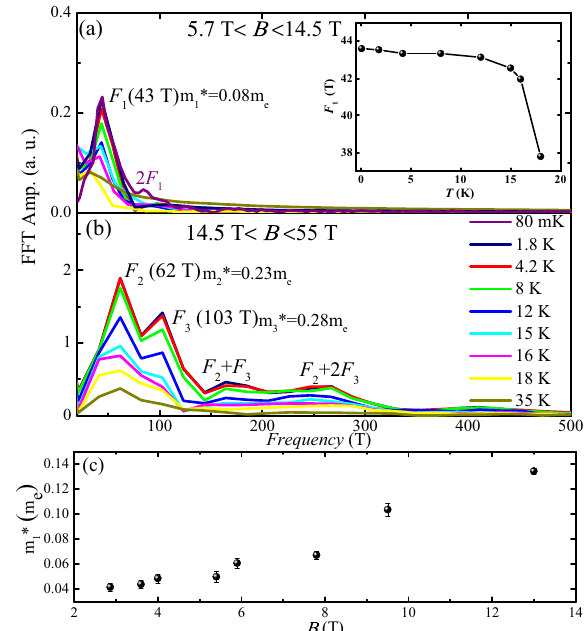
Fig. 2 FFT analyses of quantum oscillations in PrAlSi. a , b The frequency ( T ) dependence of the fast-Fourier-transformation ampli- tude of SdH oscillations measured at various temperatures with B ∥ c in the pulsed fi eld. With the fi eld lower than 14.5 T, only one fundamental frequency exists in ( a ). Two main higher frequencies and harmonic terms are shown in b with the fi eld above 14.5 T. The inset shows the temperature-dependent frequency F 1 extracted from ( a ). c The corresponding effective mass of F 1 as a function of magnetic fi eld B was obtained from the analysis of the QO peaks in a static fi